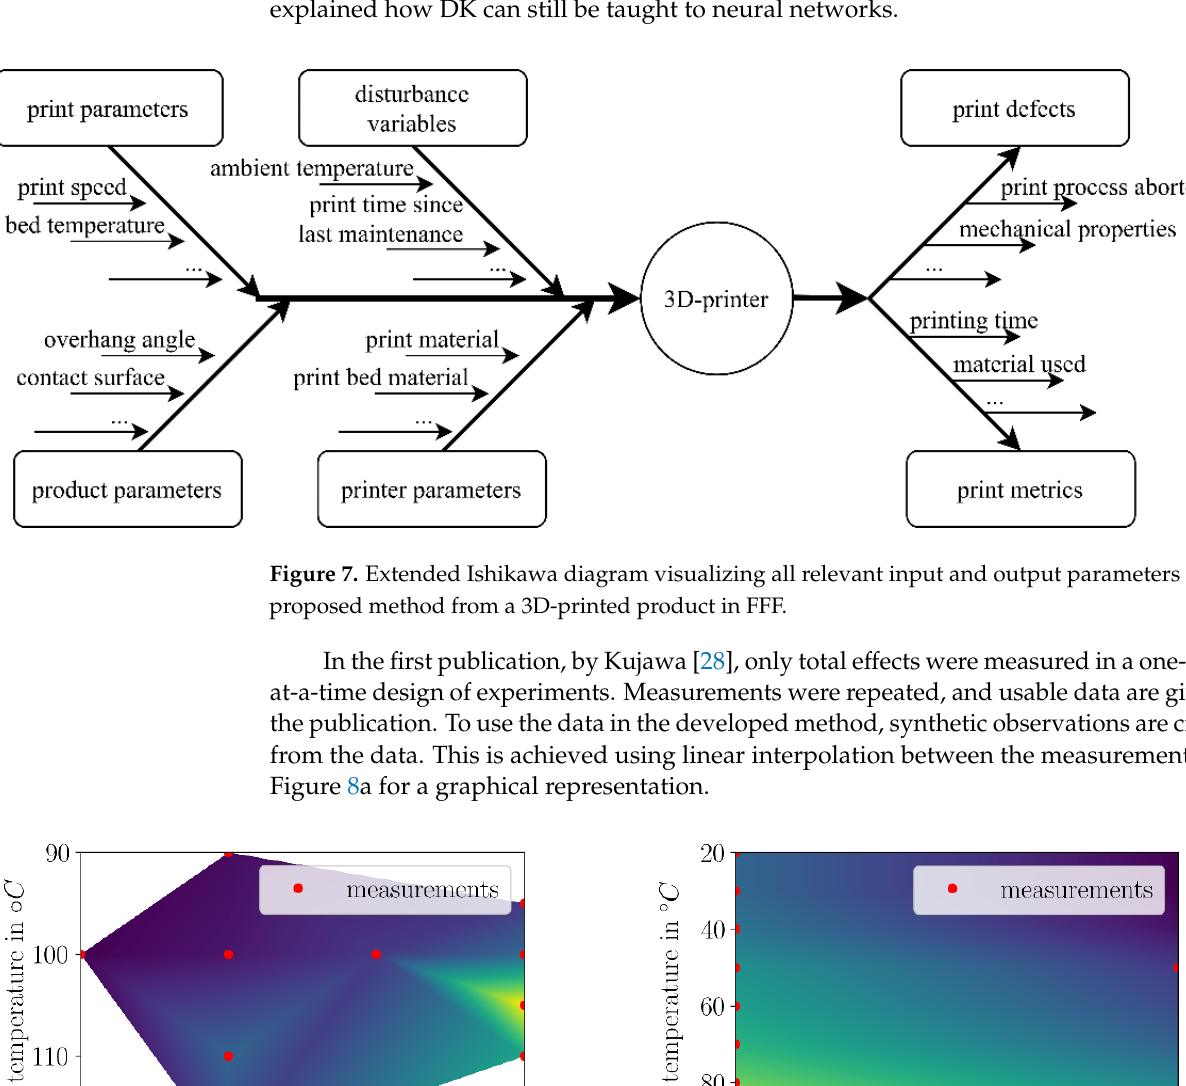
Figure 7. Extended Ishikawa diagram visualizing all relevant input and output parameters for the proposed method from a 3D-printed product in FFF.